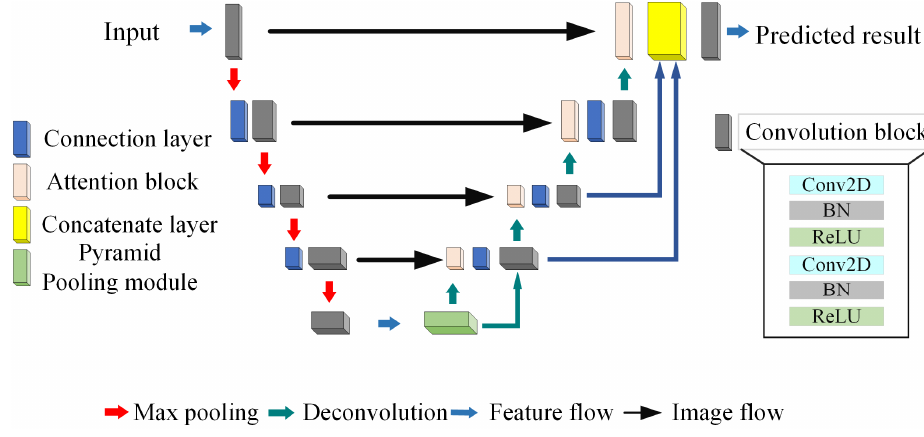
Figure 4. Structure of the water extraction network.